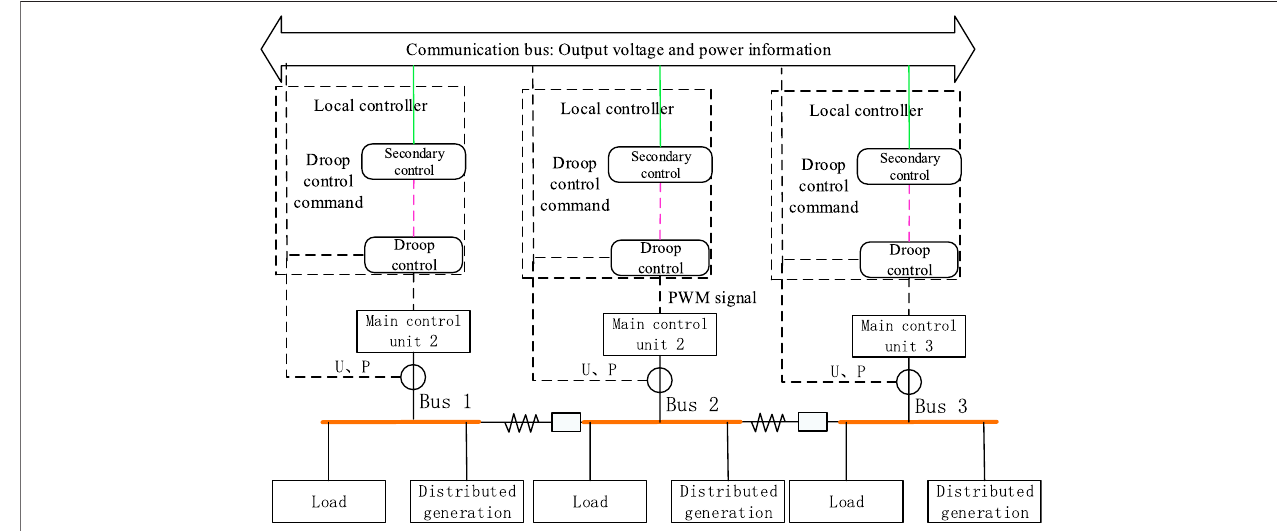
FIGURE 6 | Schematic diagram of centralized communication and distributed control structure.